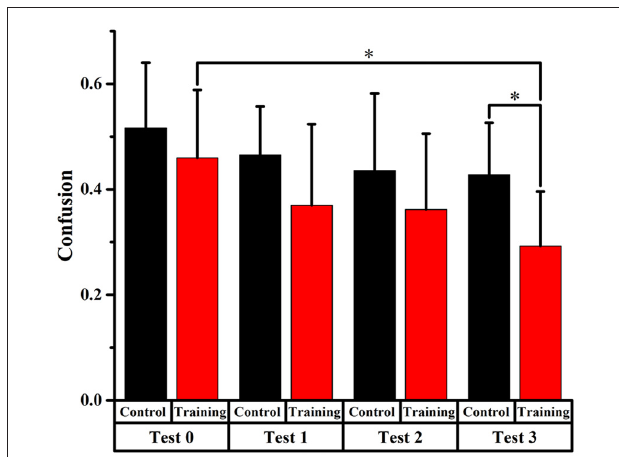
FIGURE 6 | Comparison of front-back confusion ratio for the audiovisual training and control groups between pre- and post-test at untrained angles. ∗ meant the difference was significant ( P < 0.05).